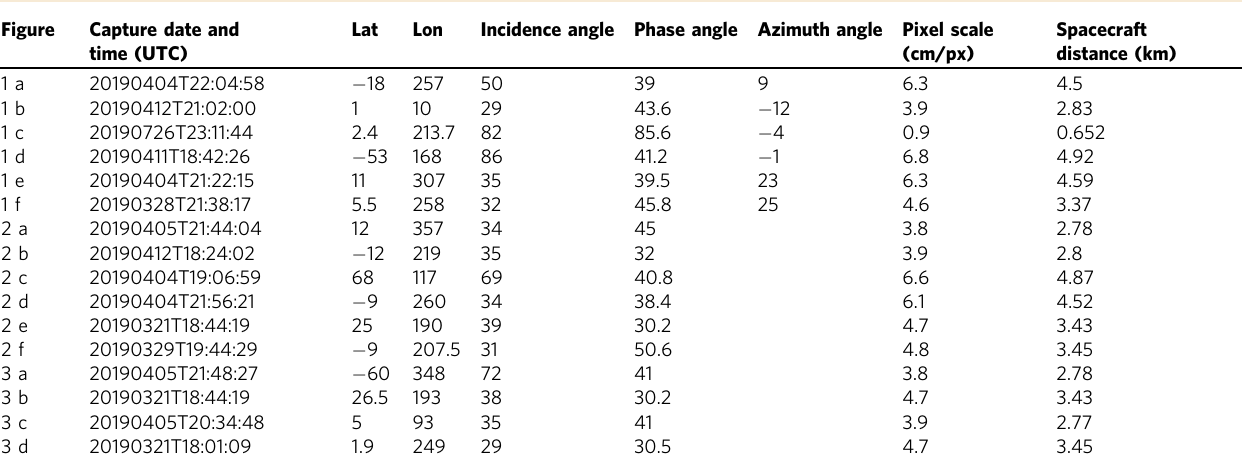
Capture date and Lat Lon Incidence angle Phase angle Azimuth angle Pixel scale time (UTC)